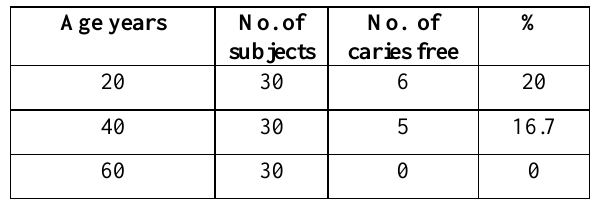
Table 2: Dunnett’s T3 between DMFs fraction among different